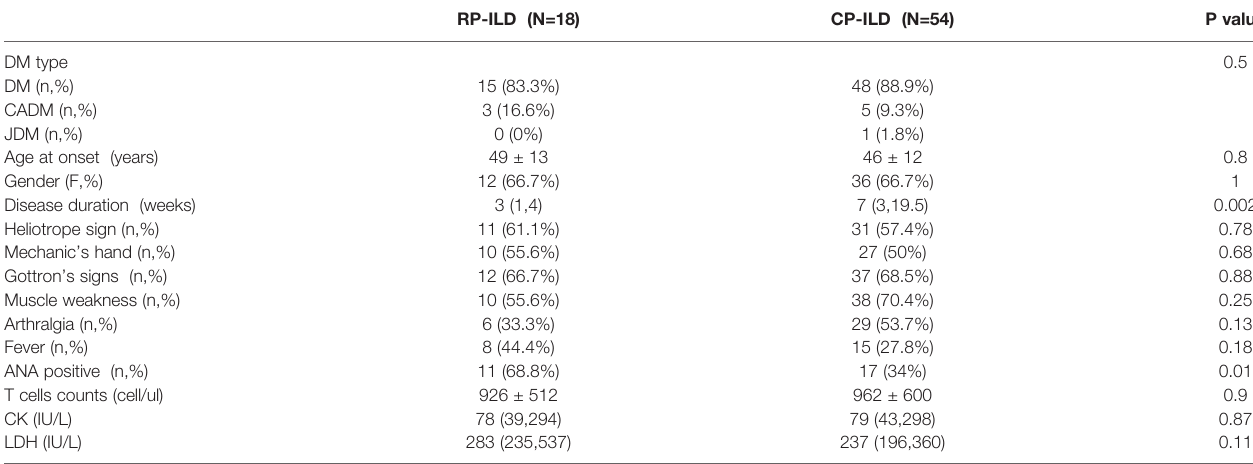
TABLE 2 | Prevalence and characteristics of RP-ILD in DM-ILD patients with negative MSA/MAA